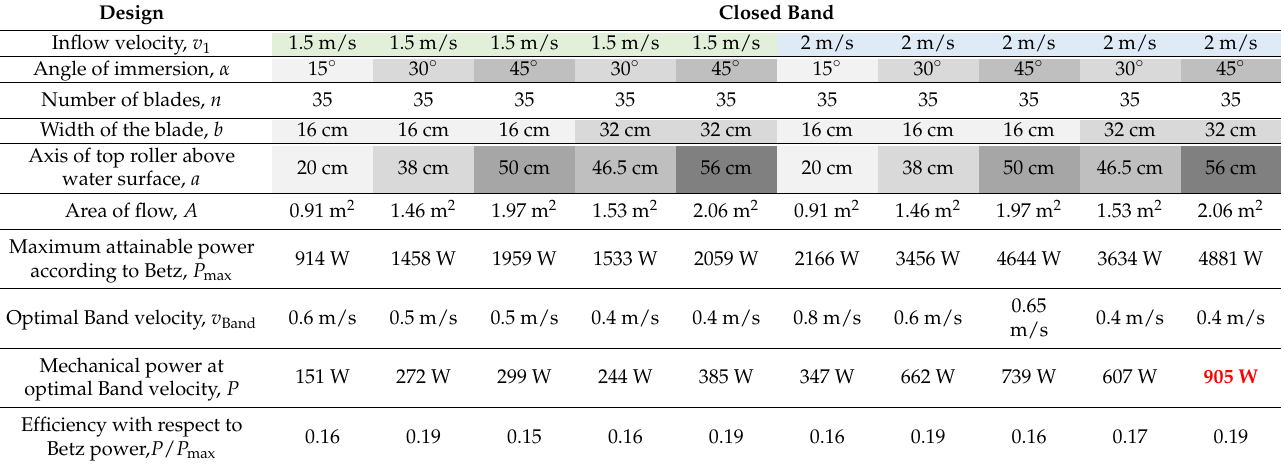
Table 5. Result summary I for Closed-Band ECB (red color is one of the optimum variants which is mentioned later in the conclusions).